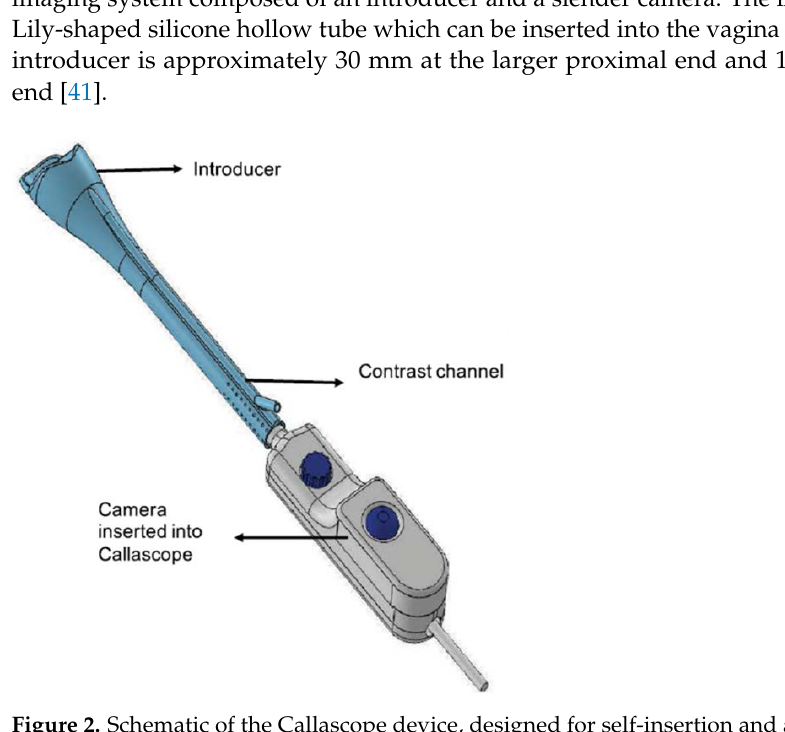
Figure 2. Schematic of the Callascope device, designed for self-insertion and aiming of the uterine cervix (Reprinted from Ref. [40]).